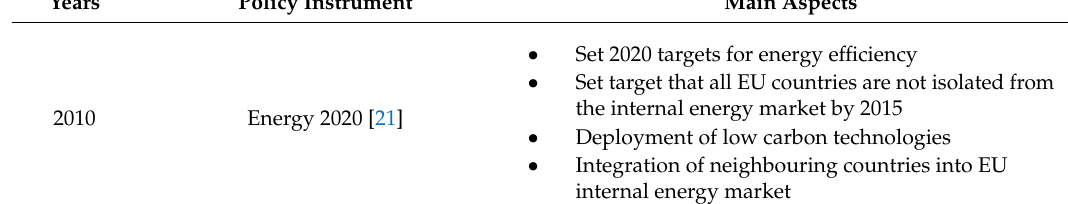
Table 2. Policy instruments for the smarter and more sustainable EU electricity. Source: data from [15,21–23].